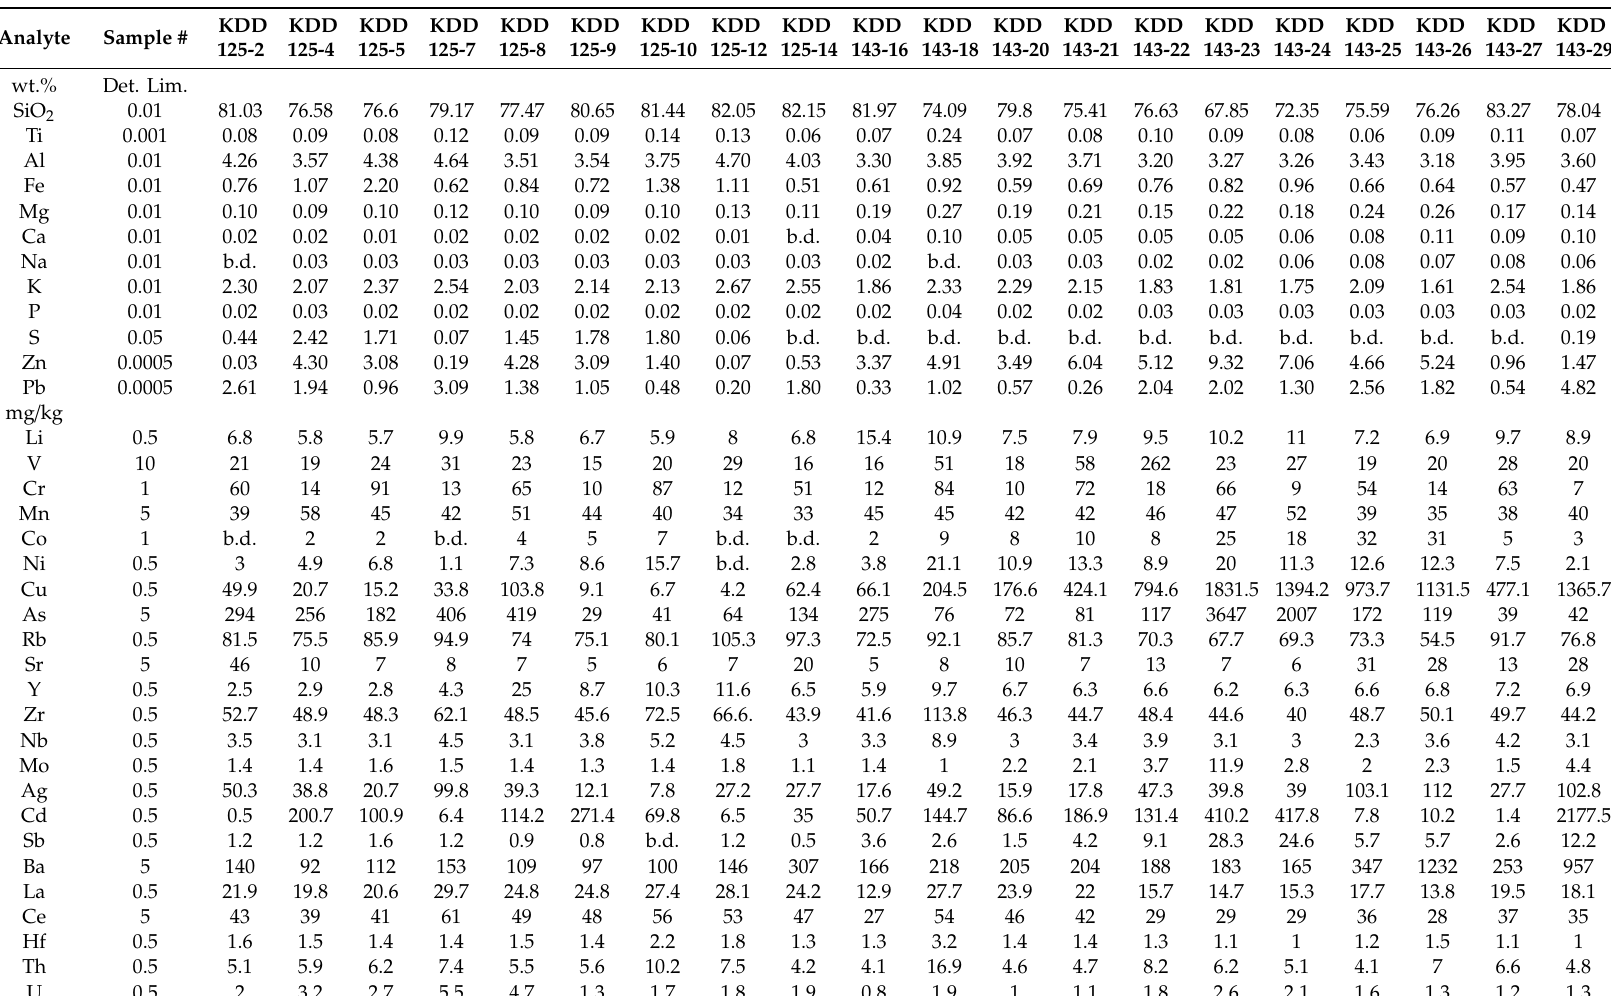
Table A4. Chemical analyses (wt. %) of selected Kihabe samples (ICP-ES-MS).